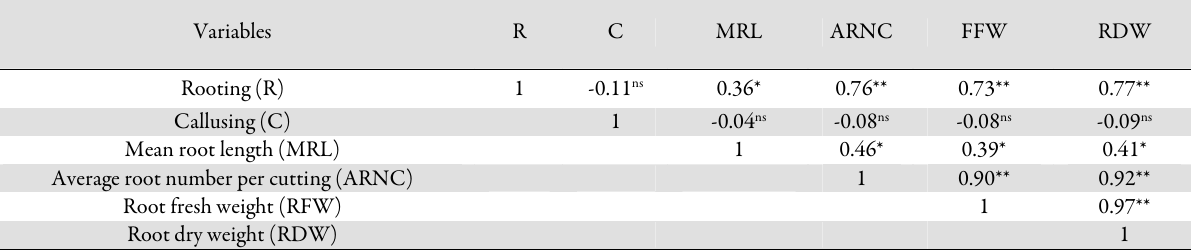
Tab. 2. Pearson’s correlation coefficients for quantitative determinations in rooting of Cornelian cherry ( Cornus mas